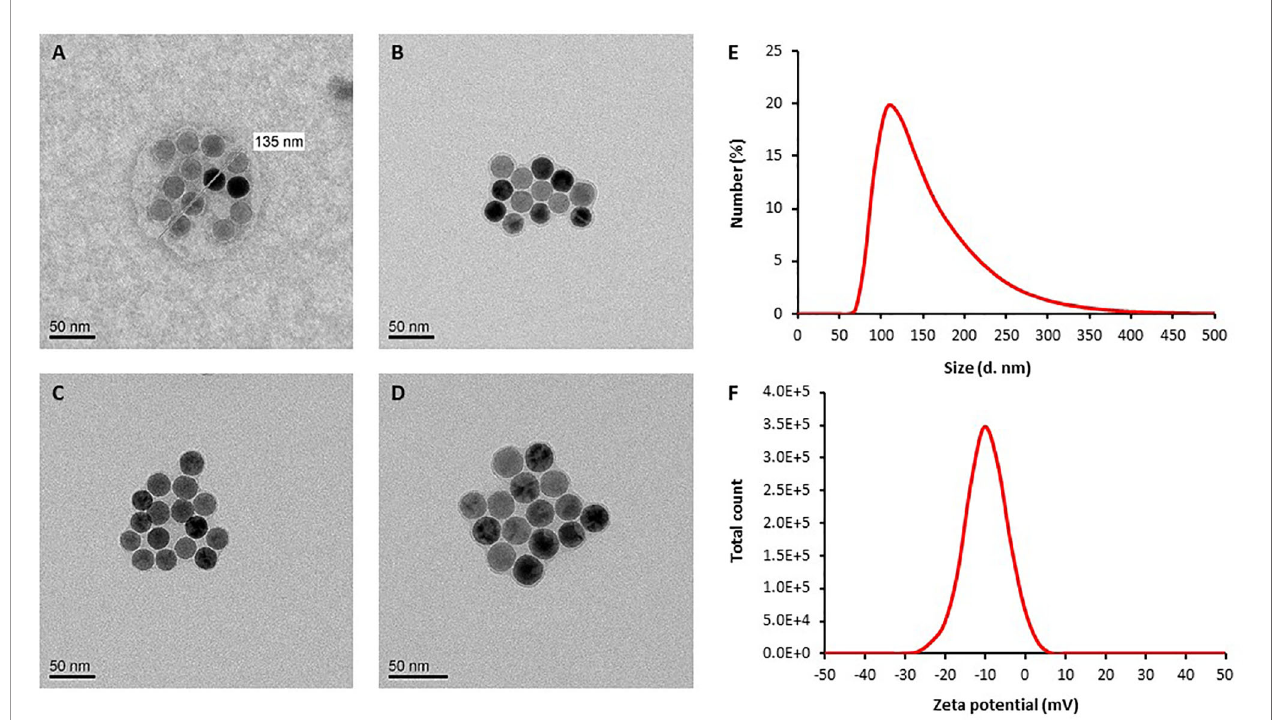
FIGURE 1 | Representative TEM images of SaNPs. (A) SaNP with spherical shape. (B – D) SaNPs with amorphous (non-spherical) shape. Images were obtained using a Tecnai G2Spirit Twin T-12 electron microscope with an accelerating voltage of 120 kV. (E) Size (diameter) distribution of SaNPs (d. nm) determined by DLS. (F) Distribution of zeta potential values determined by DLS